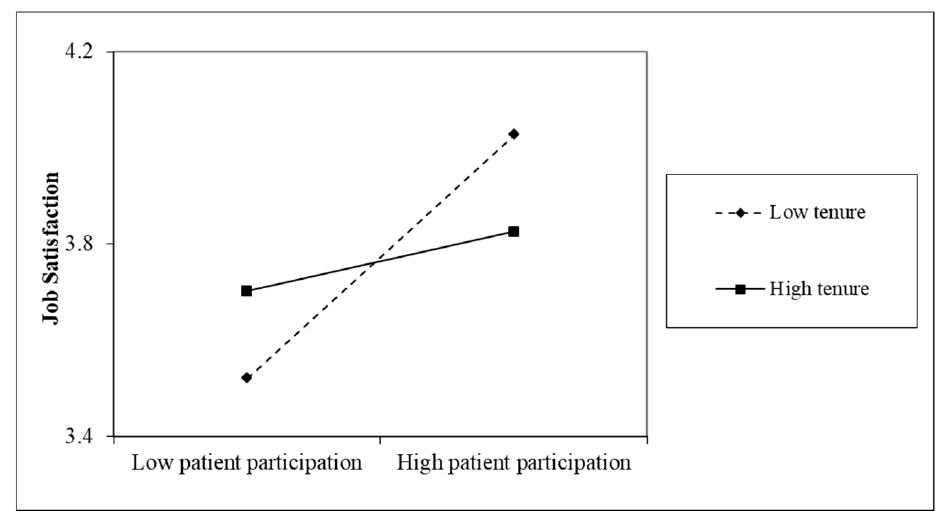
Figure 3. Simple slopes for the interaction between patient participation and age on nurse job satisfaction.